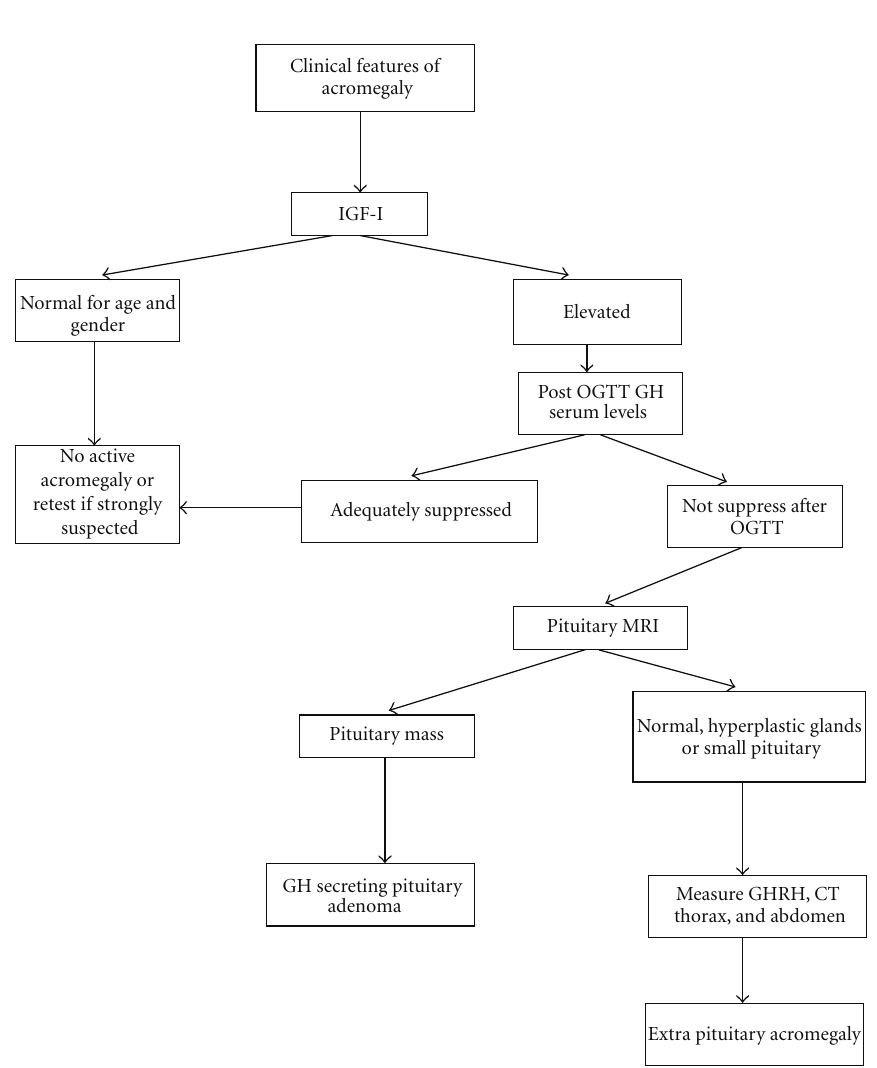
Figure 1: Algorithm for the diagnosis of acromegaly (modified from: Cordero and Barkan [61] and Giustina et al.